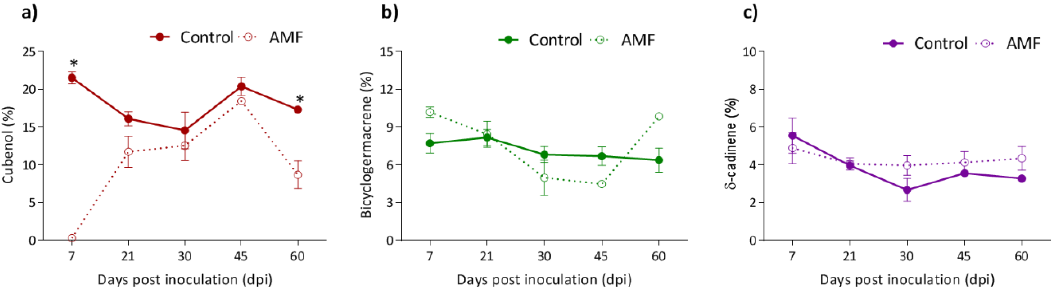
Figure 2. Variation of the main volatile compounds of leaves of Piper nigrum in association with arbuscular mychorrhizal fungi. (a) cubenol; (b) bicyclogermacrene; (c) δ -cadinene. Asterisks on the bars represent statistically significant differences between the treatment and control groups, at the 5% probability level, by Bonferroni. AMF, arbuscular mycorrhizal fungi.